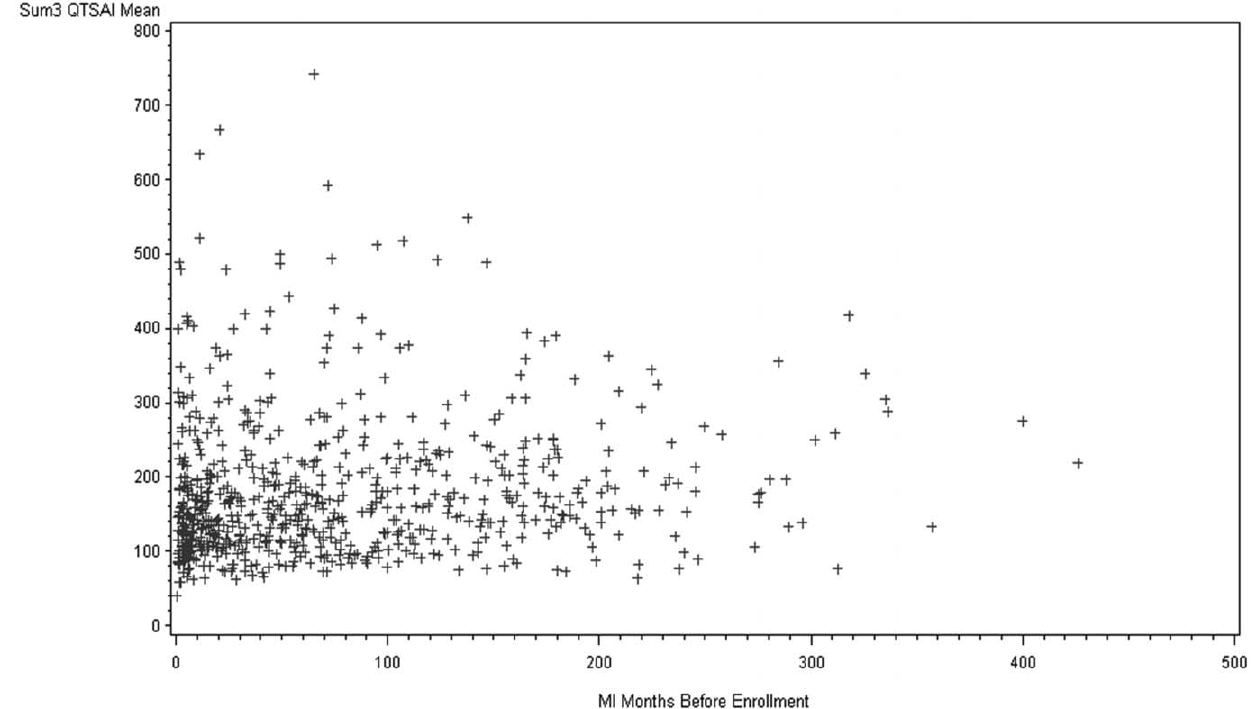
Figure 2. Correlation between the time after myocardial infarction and SAI QRST. P=0.003.